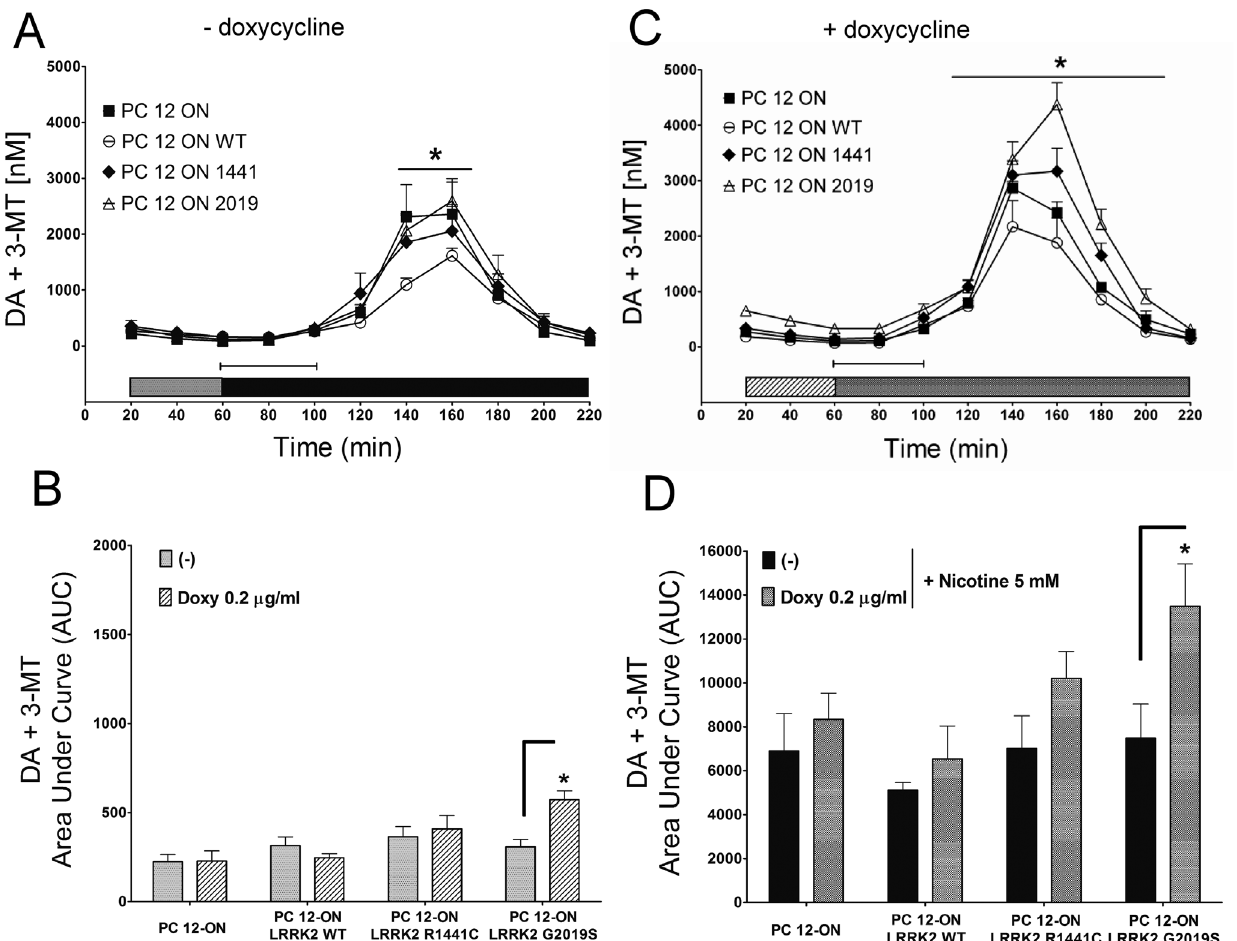
Figure 2. Effect of LRRK2 expression on dopamine (DA + 3-MT) extracellular level. PC12-derived cell lines were left untreated (A) or treated (C) for 48 h with 0.2 m g/mL doxycycline. After 60 minutes of stabilization, three baseline dialysates were collected at 20-minute intervals [gray bars in panel (A), and gray bars with stripes in panel (C)]. Starting from 60 minutes, nicotine was infused for 60 minutes (capped lines). Microdialysates were continuously recovered during drug infusion and after nicotine discontinuation [black bars in panel (A), and dotted bars in panel (C)]. Values are mean 6 SEM and refer to dopamine concentrations in dialysates. Statistical significance was assessed using analysis of variance (ANOVA) for differences over time determined by Newman-Keules t test and unpaired t -tests. * p , 0.05 compared with pertinent baseline values of all groups. Graphs in panel (B) and (D) represent the area under curve (AUC) values. (B) Basal dopamine concentration in dialysates of PC12 cell lines untreated (gray bars corresponding to the same color in panel A) or treated with 0.2 m g/mL doxycycline [gray bars with stripes corresponding to same color in panel (C)]. (D) Dopamine concentrations in dialysates integrated after nicotine administration in PC12 cell lines untreated [black bars corresponding to same color in panel (A)] or treated with 0.2 m g/mL of doxycycline [dotted bars corresponding to same color in panel (C)]. AUC values are mean 6 SEM. * p , 0.05 vs corresponding control. doi:10.1371/journal.pone.0077198.g002 by AUC of secreted DA indicates an increase of 22% (although (Figure 2B bars) or presence of doxycycline (Figure 2B barred not statistical significant) and 61% (p , 0.05), respectively for bars), while the DA + 3-MT nicotine-induced release is represented LRRK2 R1441C and LRRK2 G2019 (Figure 2D). by the AUC related to points 80–220 minutes in absence (Figure 2D black bars) or presence of doxycycline (Figure 2D Under the same experimental conditions, we measured dotted bars). The expression of LRRK2 G2019S induces an 85% extracellular levels of DOPAC + HVA. A significant change both increase (p , 0.05) vs corresponding control in the basal level of in the basal condition and after nicotine infusion is observed total extracellular DA (DA + 3-MT), as shown in figure 2C (20–40– following doxycycline treatment in PC12 cells expressing 60 minutes) compared to 2A (20–40–60 minutes) and quantified LRRK2 WT or LRRK2 R1441C (Figure 3A–B–C–D). In particular by the AUC in Figure 2B. In contrast, under the same the values are 2 61.4% for WT and 2 51.7% for LRRK2 R1441C in experimental conditions expression of either LRRK2 WT or doxycycline treated samples and 2 64.9% for WT and 2 45.3% for LRRK2 R1441C does not induce a significant increase in total DA R1441C mutant by doxycycline and nicotine treatment. No extracellular levels (Figure 2A–C and quantified in 2B). Interest- significant differences were observed in PC12-ON cells or ingly, the presence of mutant LRRK2 determines an increase in expressing the LRRK2 G2019S mutant. nicotine-induced DA compared to PC12-ON or LRRK2 WT cells To evaluate the importance of LRRK2 kinase activity on (Figure 2C 60–220 minutes vs 2A 60–220 minutes). Quantification increased DA extracellular level, we used the LRRK2 inhibitor